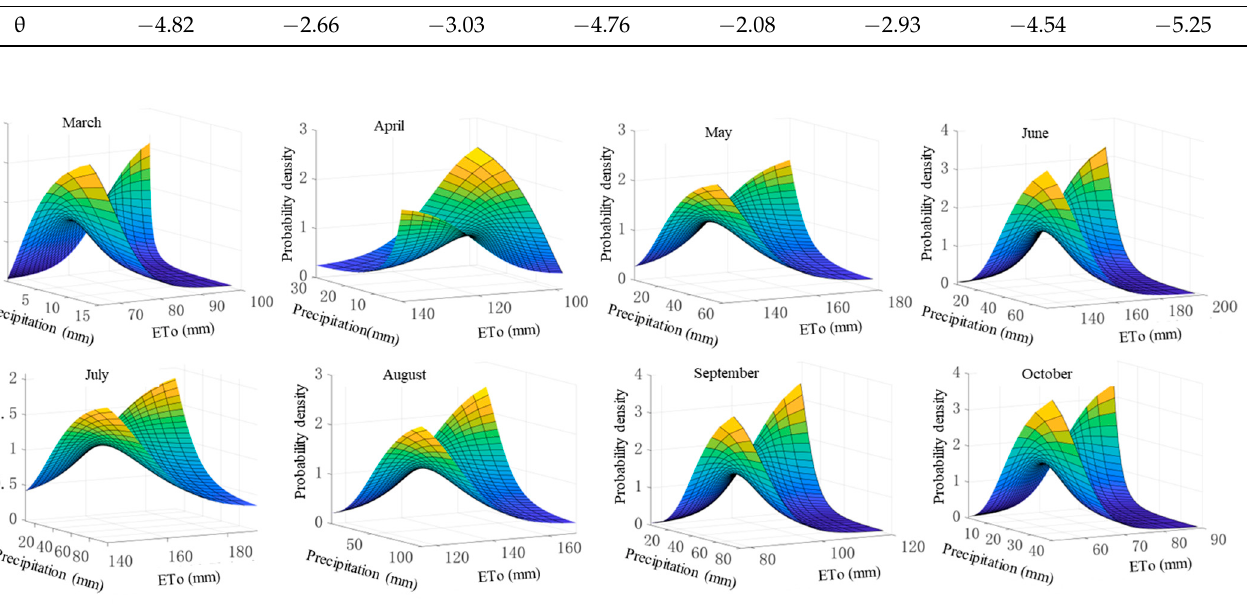
Figure 9. Probability density diagram of joint distribution of precipitation and reference.